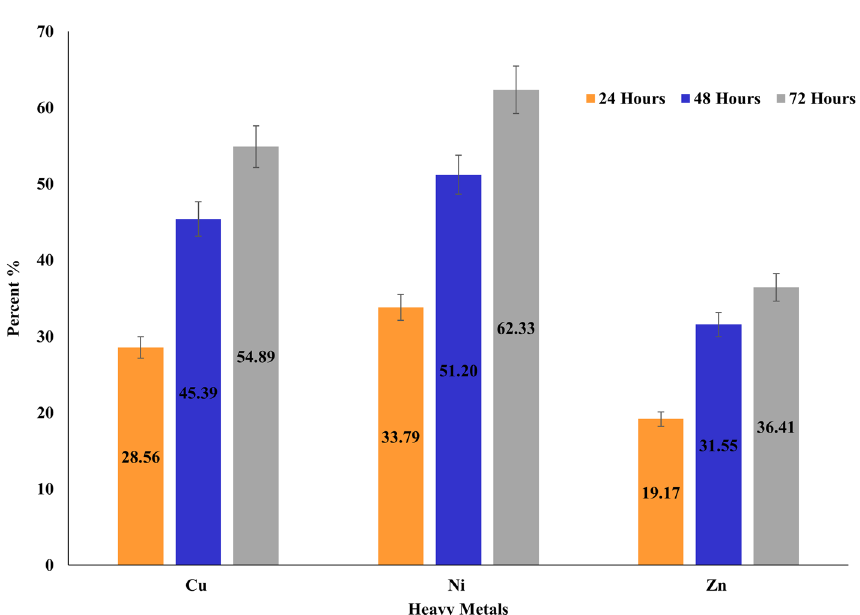
Figure 3. Reduction of Cu, Ni, and Zn by A. sobria after 24, 48, and 72 h of